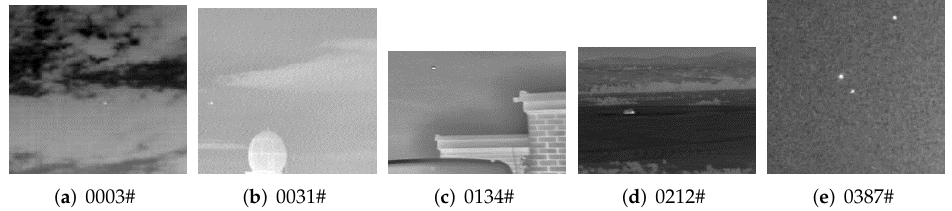
Figure 7. Examples of a single-frame infrared small target image